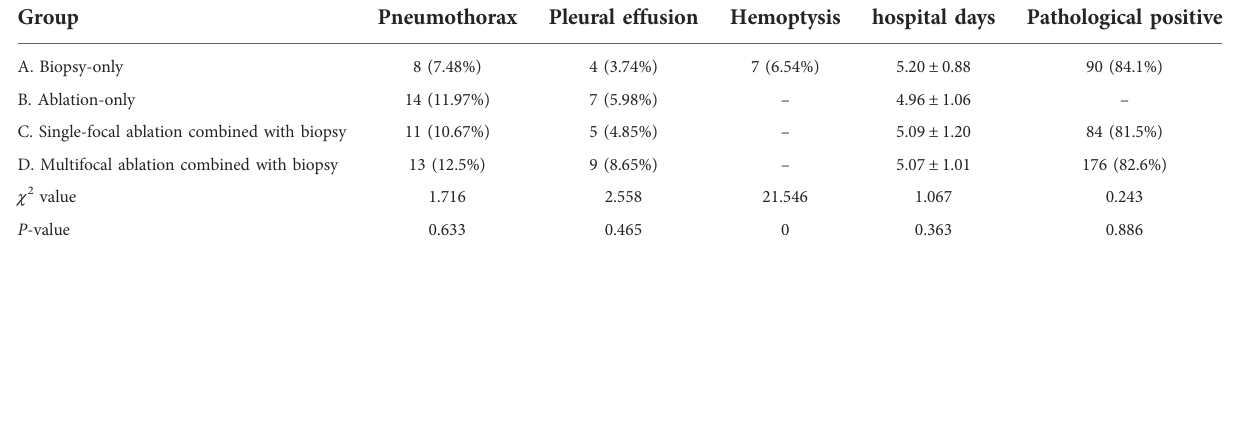
TABLE 2 Complications within 24 h after operation in each group